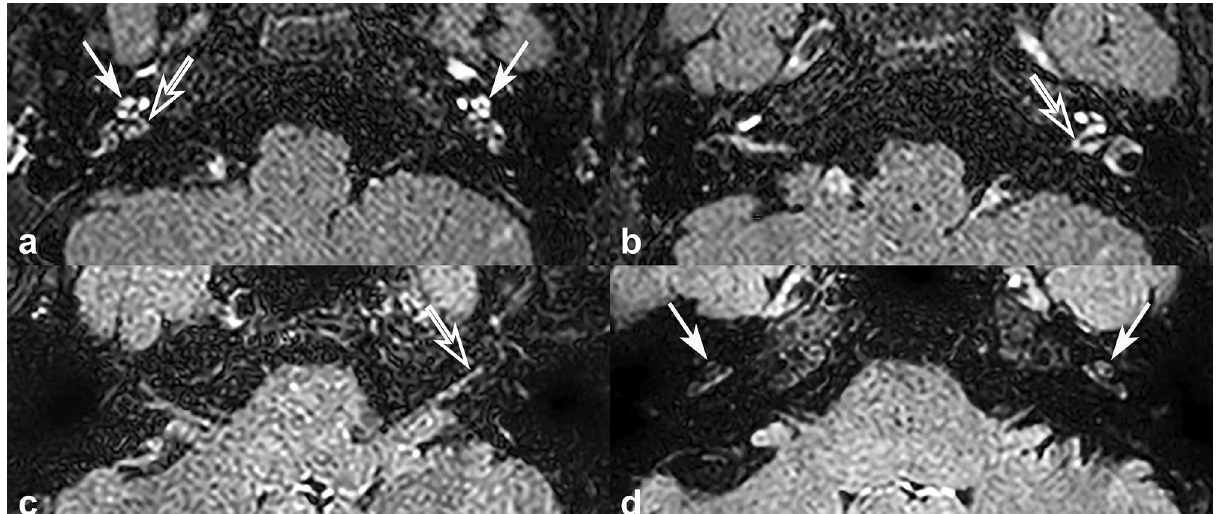
Figure 3. Representative cases of CINCA syndrome. ( a , b ) A 13-year-old male diagnosed with CINCA syndrome presented with intense inner ear enhancement in bilateral cochlea (arrows) and strong enhancement of bilateral cochlear nerves (empty arrows) on post-contrast FLAIR image (postFLAIR). ( c ) A 42-year-old female diagnosed with CINCA syndrome presented with strong enhancement of left cochlear nerve on postFLAIR (empty arrow) compared to enhancement of the cochlea. ( d ) A 38-year-old female diagnosed with CINCA syndrome presented with postFLAIR-enhancement of bilateral cochlea (arrows), but absence of enhancement of the cochlear